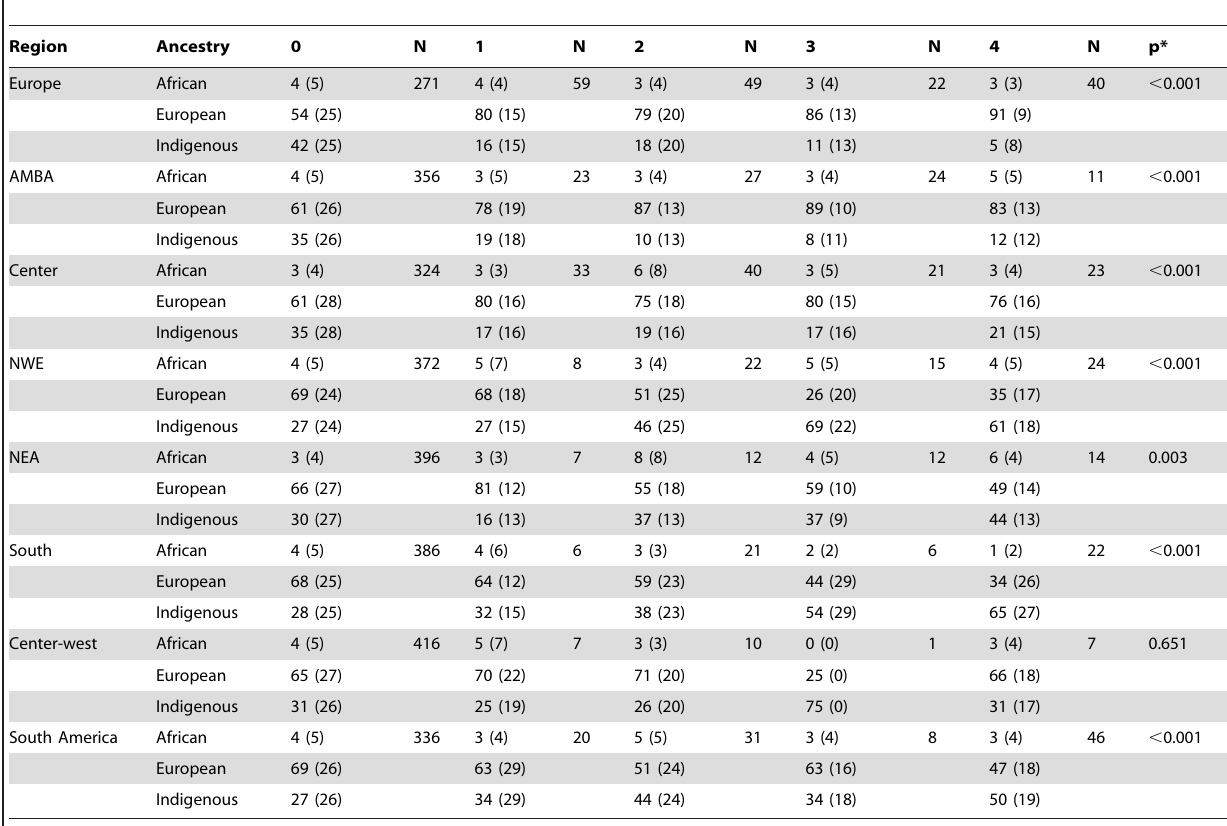
Table 2. Average percent ancestry (SD) by number of grandparents born in major regions of Argentina, Europe or other Latin American